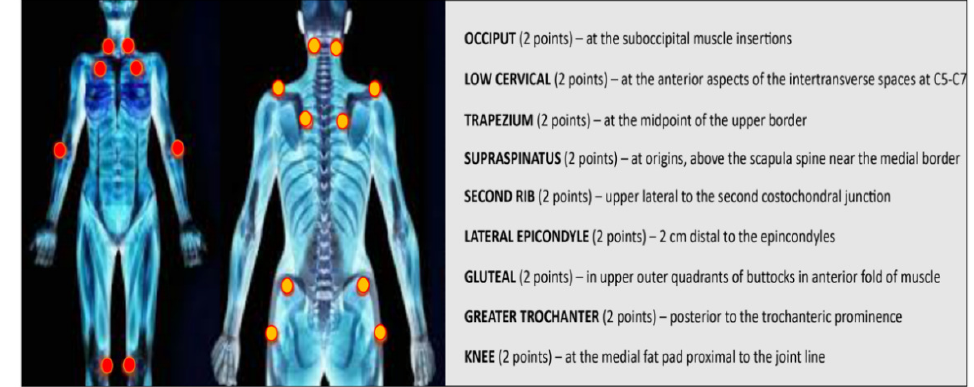
Figure 1. The dots indicate the 18 tenderness points important for the diagnosis of FM.